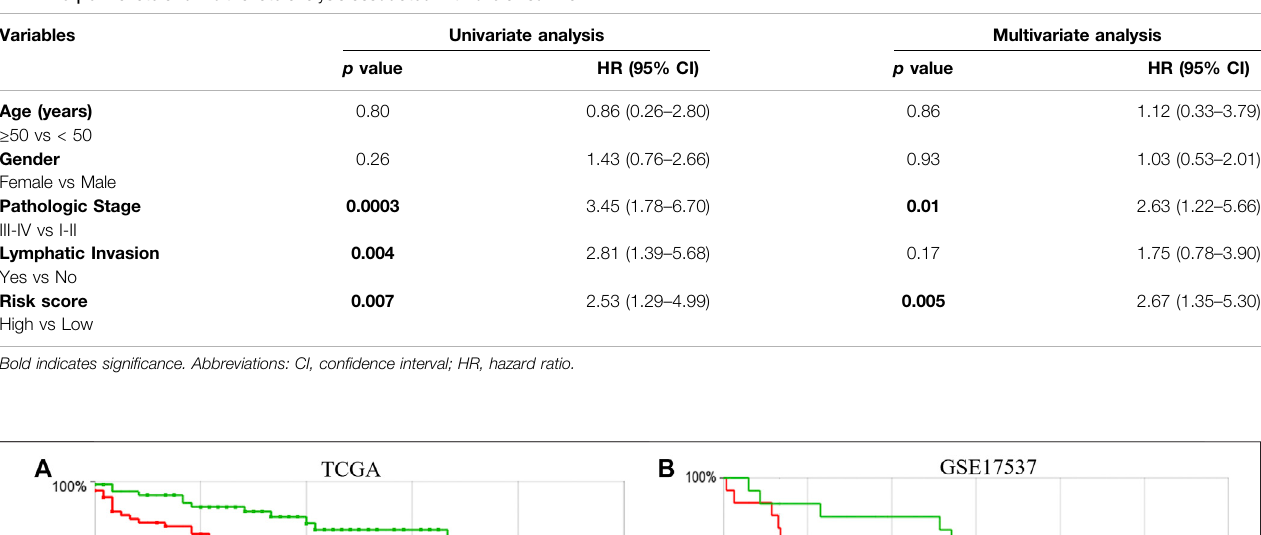
TABLE 3 | Univariate and multivariate analysis associated with overall survival.